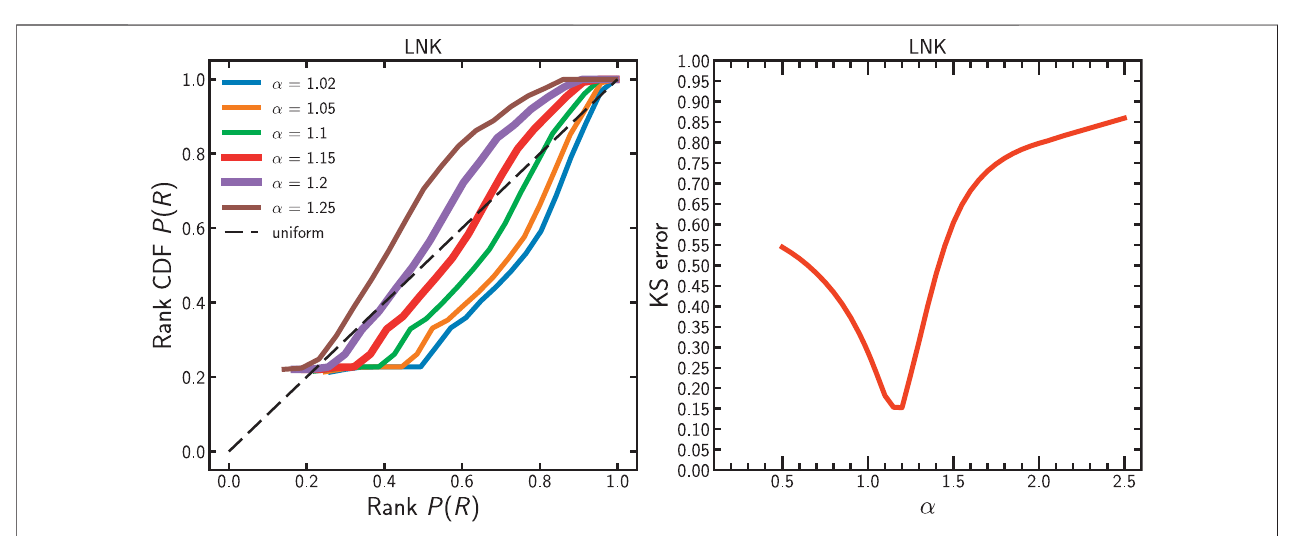
FIGURE 8 | USDT. Rank function for different α . KS distance. α value minimising